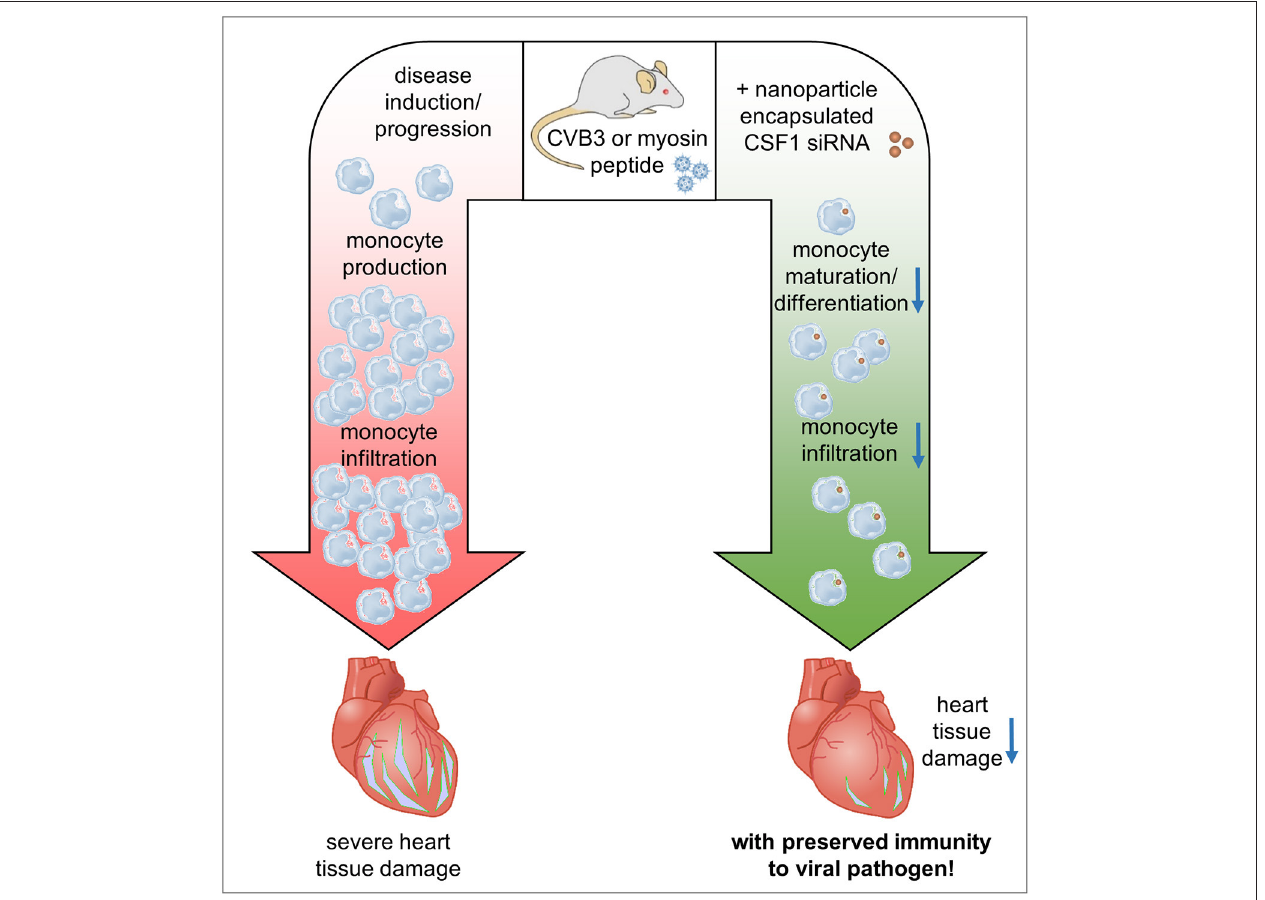
FIGURE 8 | Graphical synopsis: The CSF-1 axis is induced in patients with acute myocarditis. Based on the preponderant role of CSF-1 for monocyte differentiation/maturation and the disease-modifying function of monocytes during the course of inflammatory heart disease, we investigated how silencing of CSF-1 in monocytes/macrophages using nanoparticle encapsulated siRNA influences heart tissue damage during the onset of acute viral myocarditis and upon manifestation of acute inflammation in an autoimmune myocarditis model. Silencing of the myeloid CSF-1 axis was beneficial for preventing inflammatory tissue damage in the heart and preserving cardiac function at acute and chronic disease states without compromising innate immunity’s critical defense mechanisms.